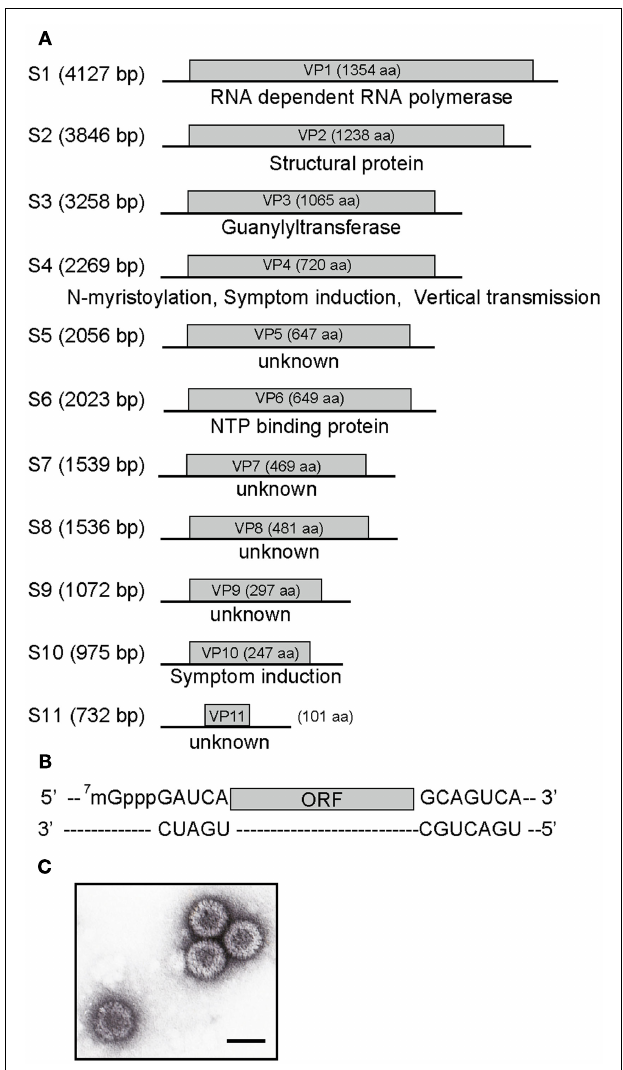
FIGURE 1 | MyRV1 genome organization and virion morphology. (A) Diagram illustrating the organization of the MyRV1 genome segments S1–S11. Each segment has a large single ORF corresponding between 42 and 98% of its entire size. Light gray boxes refer to ORFs and the sizes of their protein products are shown.The locations and assigned functions of encoded proteins are denoted below. RdRp, guanylyltransferase, and NTP binding protein are assigned to S1, S3, and S6.VP4 andVP10 are dispensable for replication, while they are required for normal symptom induction. (B) Basic structure of the MyRV1 genome segment.The plus-sense strand of each dsRNA segment possesses the strictly conserved 5’ pentanucleotide (5’-GAUCA—), single ORF and 3’ heptanucleotide (—GCAGUCA-3’). (C) Electron microscopy of MyRV1 virions. MyRV1 has a double-shelled particle structure of approximately 80nm in diameter. Bar represents